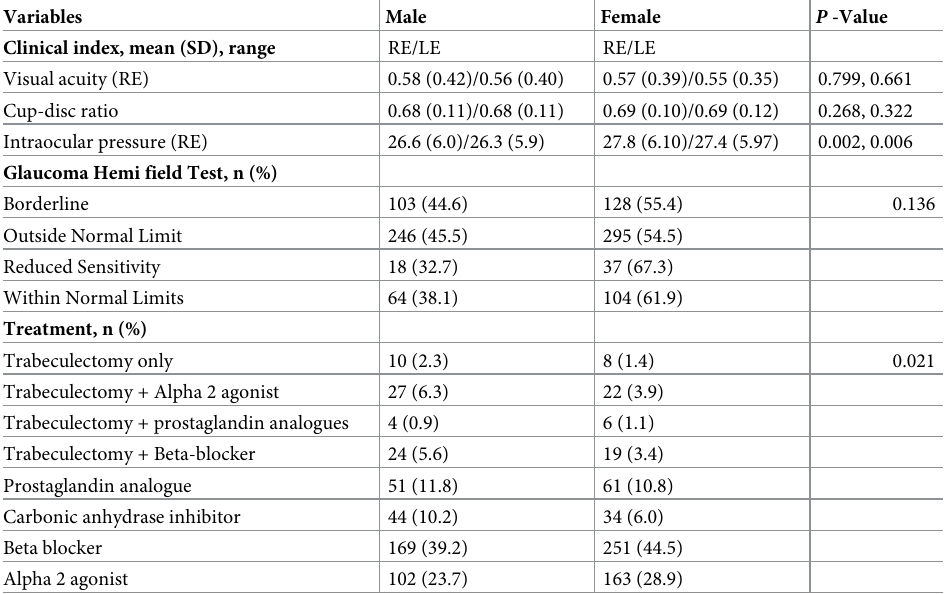
Alpha 2 agonist 102 (23.7) 163 (28.9) VA was recorded in Log MAR = logarithmic minimum angle of resolution; SD = standard deviation; RE = right eye and LE = left eye were for clinical index